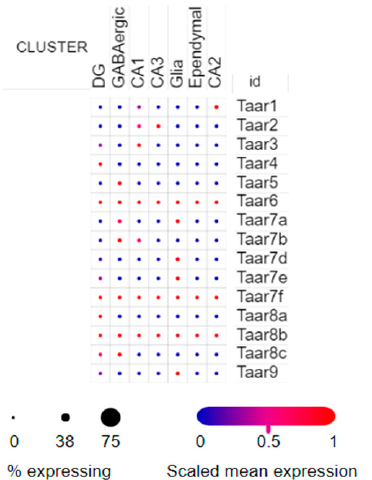
Figure 5. Distribution of TAARs expression in the murine hippocampal cell populations in the SCP1 dataset (picture was generated by the Single Cell Portal interactive interface). Expression levels are marked by color in accordance with the color scale.